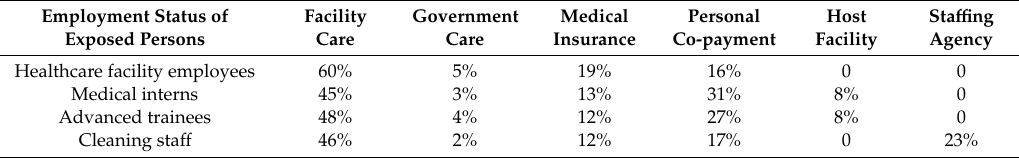
Table 6. Percentage of the cost-sharing of the post-BBF exposure